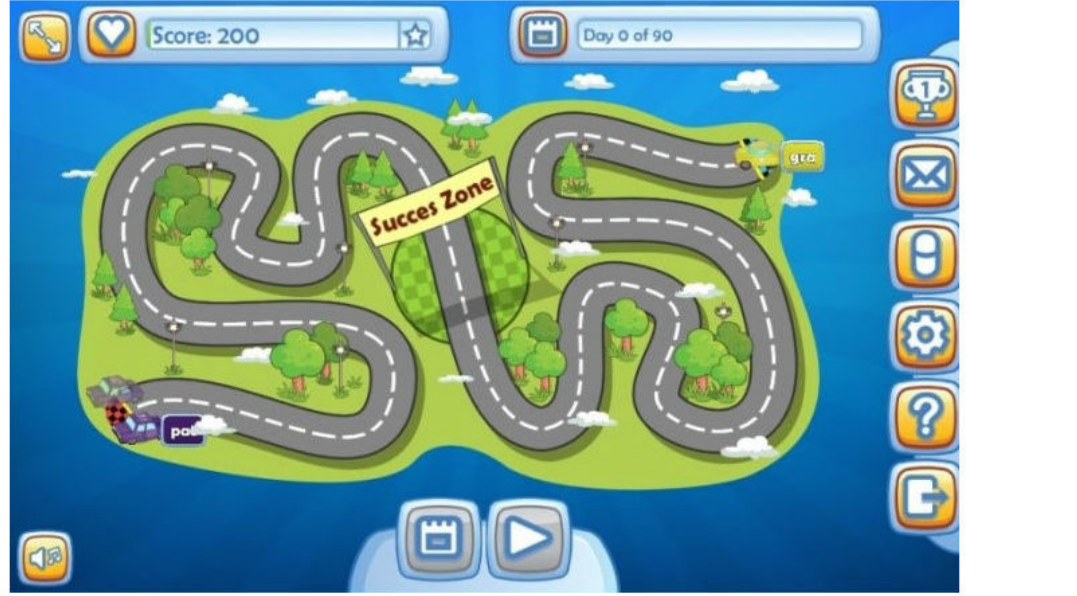
Figure 3. Screenshot of the Health Buddies app showing the home screen with the success zone in the middle where patient and grandchild meet at the end of the 90-day